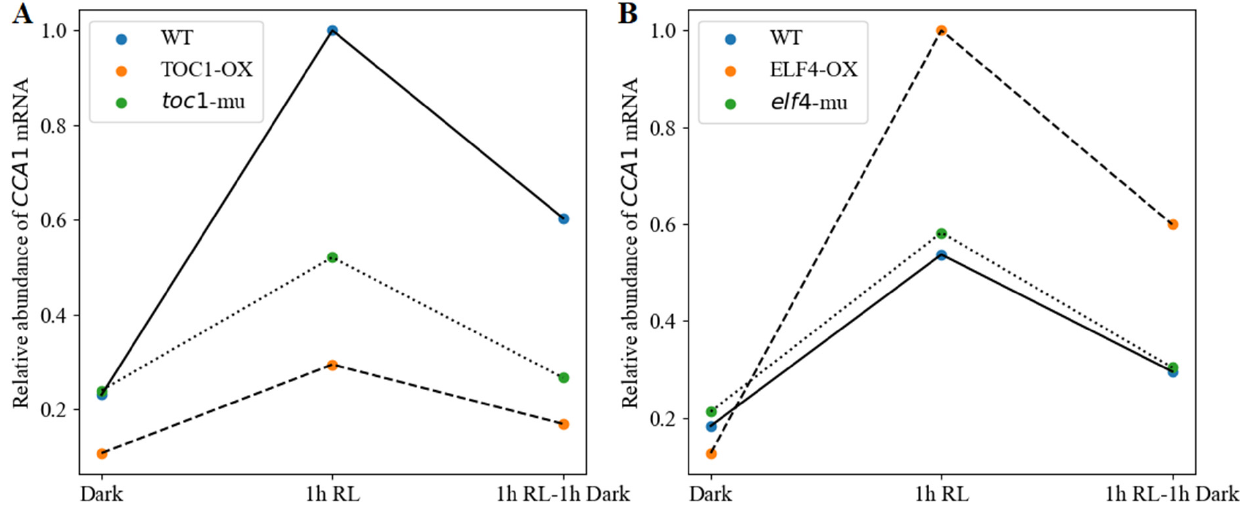
Figure 4. The red-light-mediated induction of CCA1 in WT, TOC1-OX, toc1 -mu, ELF4-OX, and elf4